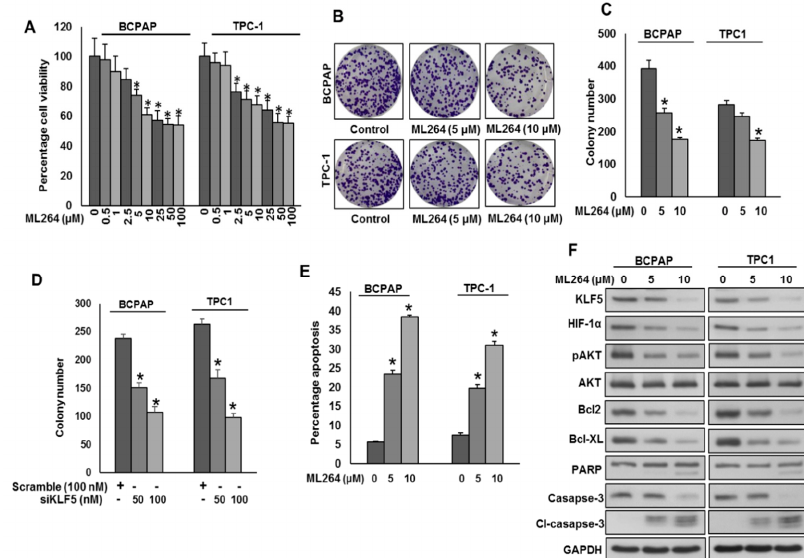
Figure 4. Downregulation of KLF5 inhibits PTC cell growth in vitro. ( A ) ML264 inhibits cell viability. PTC cells (10 4 ) were incubated with indicated doses of ML264 for 48 h. Cell viability was performed using MTT. ( B , C ) ML264 inhibited clonogenicity. PTC cells (8 × 10 2 ) after ML264 treatment were seeded into two dishes (60 mm diameter), and grown for an additional 10 days, then stained with crystal violet, and colonies were counted. ( D ) Knockdown of KLF5 decreases clonogenicity. PTC cells were transfected with scrambled siRNA and KLF5 siRNA (50 and 100 nM). After 48 h, cells (8 × 10 2 ) were seeded into two dishes (60 mm diameter), and grown for an additional 10 days, then stained with crystal violet, and colonies were counted. ( E ) ML264 induces apoptosis in PTC cell lines. PTC cells were treated with indicated doses of ML264 for 48 h and cells were stained with fluorescein-conjugated annexin-V and propidium iodide (PI) and analyzed by flow cytometry. ( F ) ML264 treatment causes inactivation of AKT and down-regulates the expression of anti-apoptotic proteins and induces the cleavage of caspase-3 and PARP. PTC cells were treated with indicated doses of ML264 for 48 h. After cell lysis, equal amounts of proteins were separated by SDS-PAGE, transferred to immobilon membrane, and immuno-blotted with antibodies against KLF5, HIF-1 α , pAKT, AKT, Bcl-2, Bcl-xL, PARP, casapse-3, cleaved casapse-3 and GAPDH as indicated. All the experiments were repeated twice with similar results. Data presented in the bar graphs are the mean ± SD of triplicates in an independent experiment which was repeated at least two times with the same results. * Indicates a statistically significant difference compared to control with p < 0.05. Western blot experiments were repeated at least two times with the same